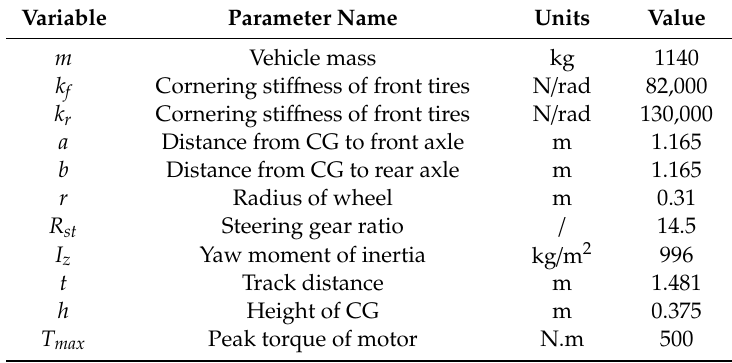
Table 1. Key parameters of vehicle